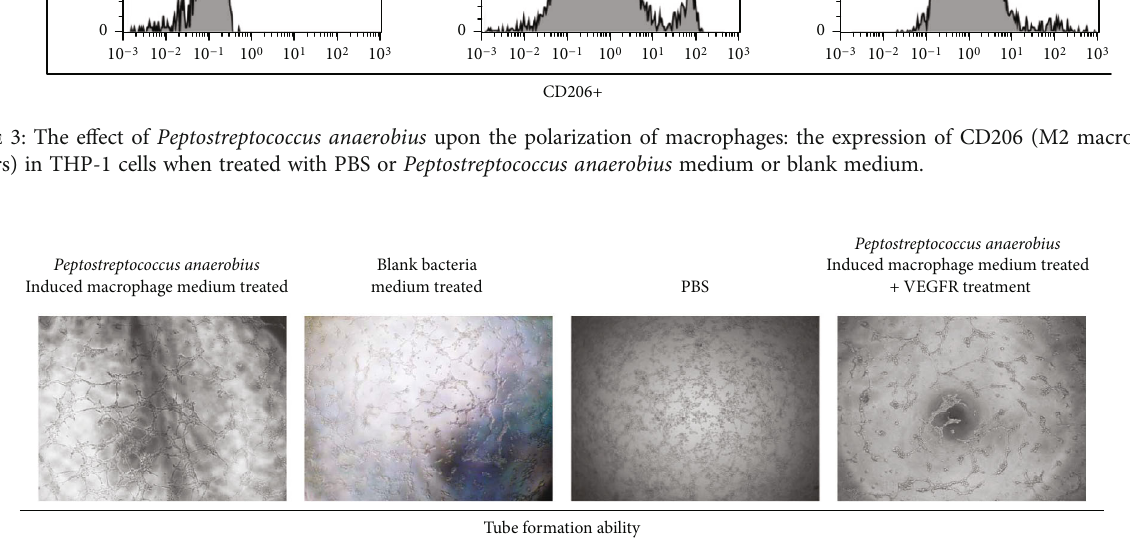
Figure 4: The e ff ect of Peptostreptococcus anaerobius upon tube formation for detecting angiogenesis ability. The tube formation ability of HUVECs after being treated with medium from Peptostreptococcus anaerobius -induced macrophages, blank bacteria medium-induced macrophages, PBS, and medium from Peptostreptococcus anaerobius -induced macrophages plus